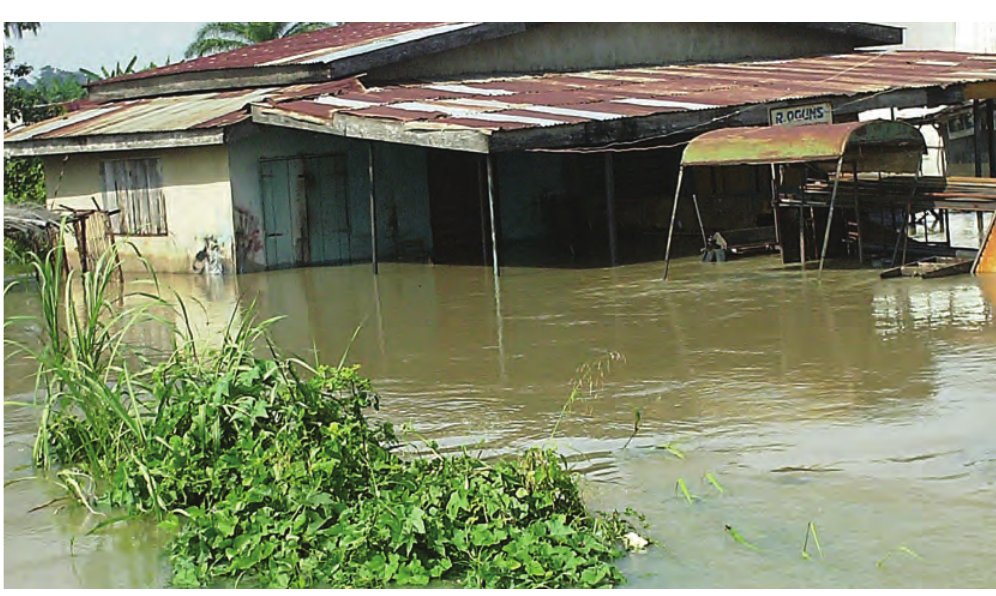
Figure 2. During a flood event in Ilorin Metropolis in